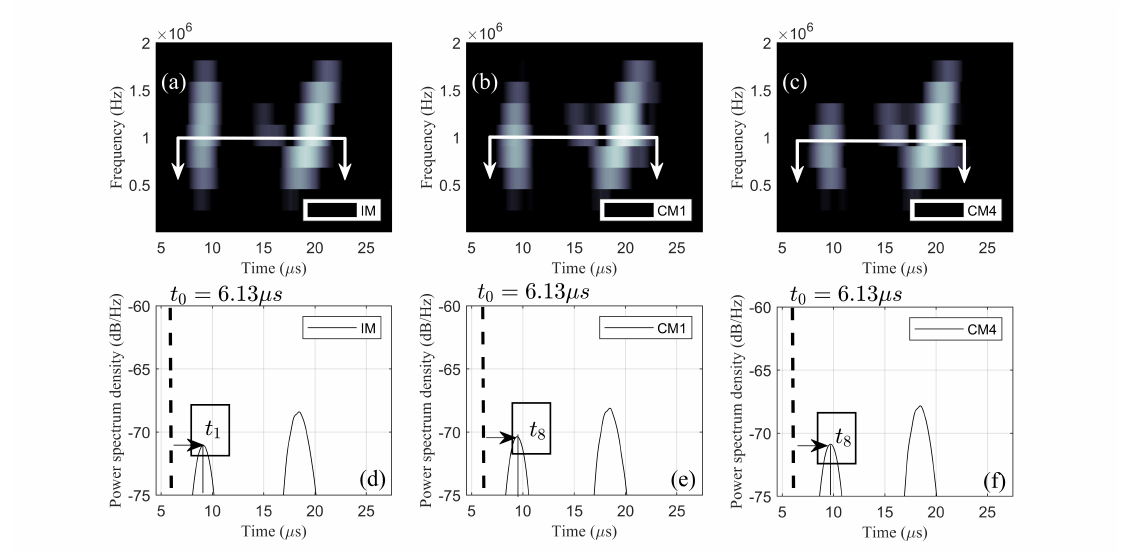
Figure 12. ( a ) Spectrogram of model IM; ( b ) spectrogram of model CM1; ( c ) spectrogram of model CM4; ( d ) spectrogram of model IM at 1 MHz; ( e ) spectrogram of model CM1 at 1 MHz; ( f ) spectrogram of model CM4 at 1 MHz.